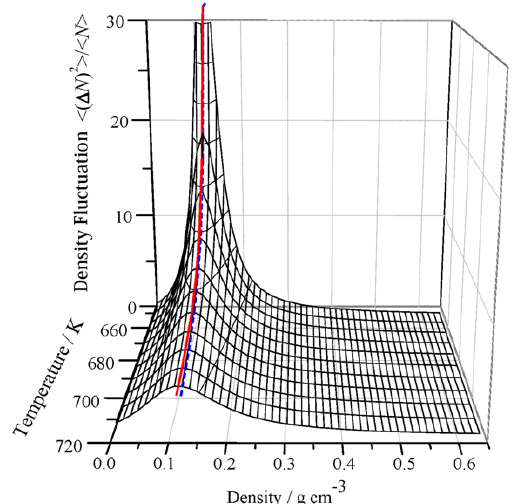
Figure 7. Behavior of the density fluctuation of supercritical H 2 O on the ρ − T phase diagram evaluated using RISM–KH theory. This figure is reprinted with permission from JCP , 2014 , 140 , 104511. Copyright 2014 AIP Publishing.